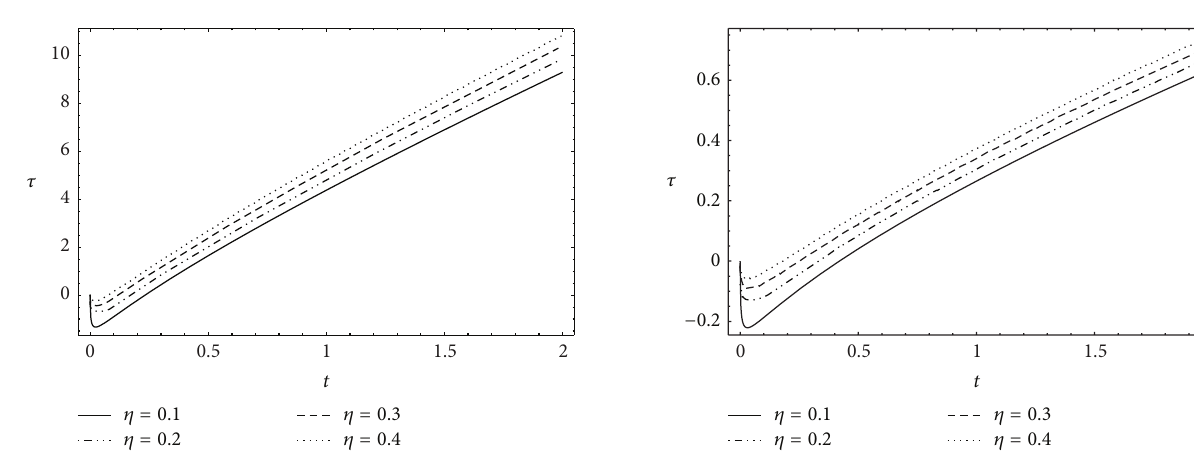
Figure 9: Variations of skin friction 𝜏 along 𝑡 for different values of 𝜂 corresponding to stepped temperature of the plate with Pr = 0.71 .